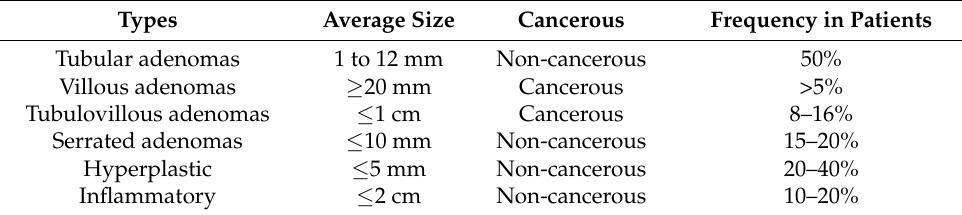
Table 1. The various classes of colorectal